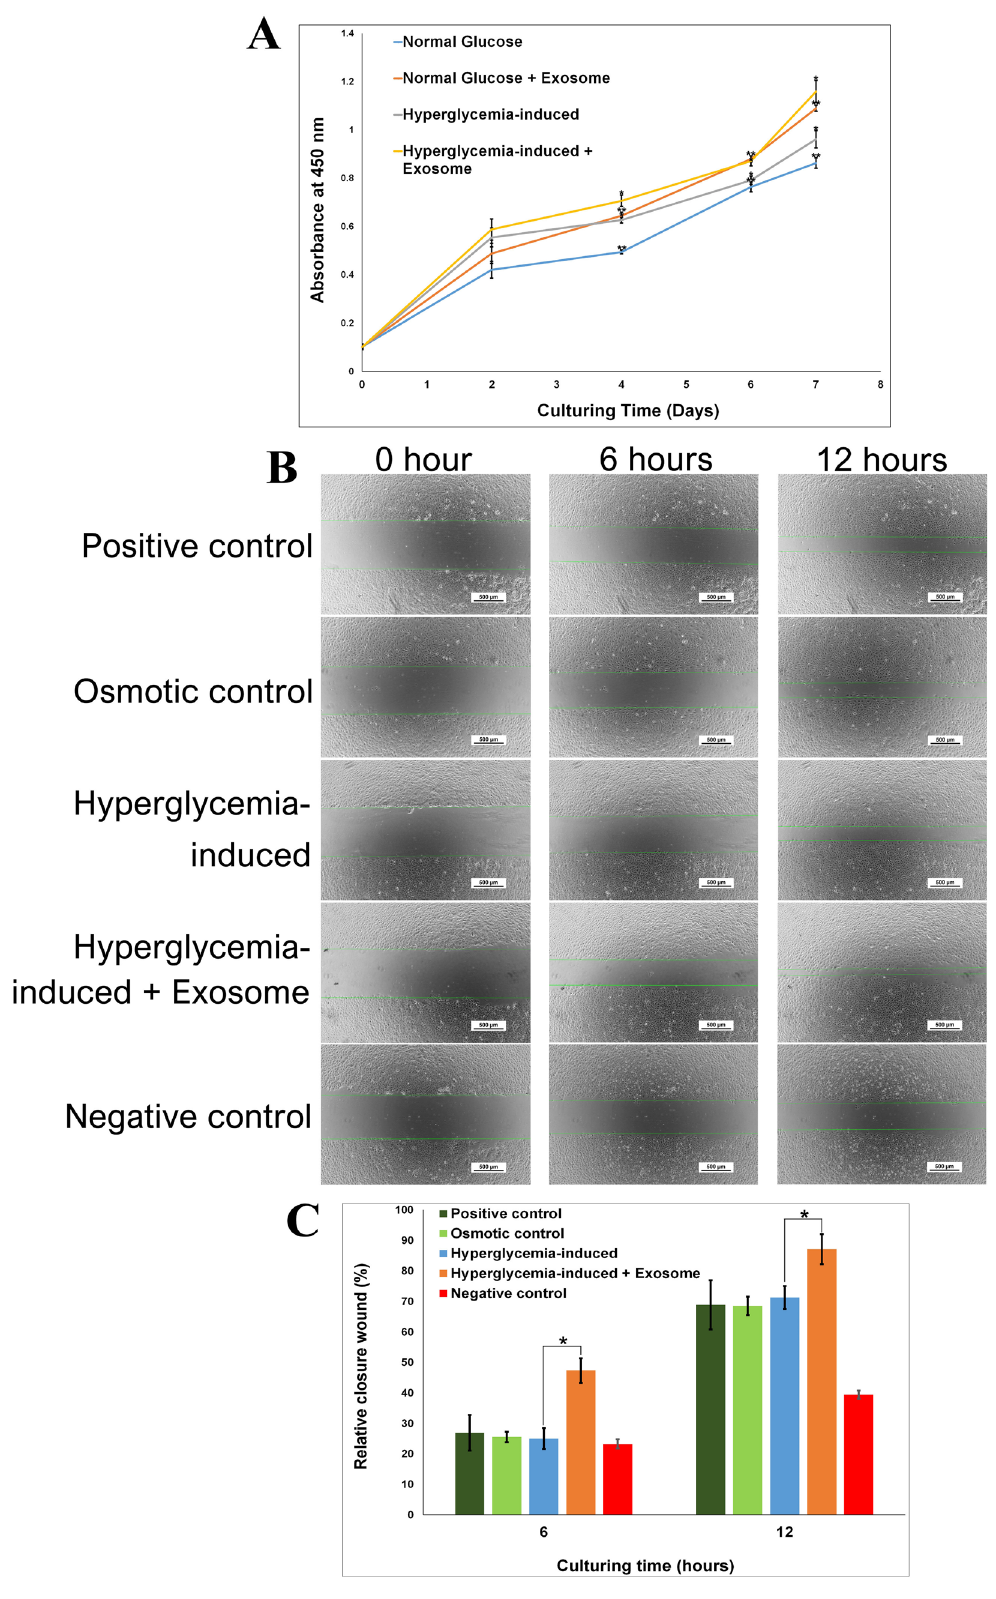
Figure 2- SHED-exosomes induce the growth and migration of hyperglycemia-induced endothelial cells. (A) The line charts represent the mean of the proliferation of HUVEC analyzed using the CCK-8 assay at different time points. **, indicates statistically significant differences between the group of exosomes and no exosome treatment in normal glucose concentration-induced HUVEC at day 4 (p=0.03), day 6 (p=0.03), and day 7 (p=0.02), * indicates statistically significant differences between the group of exosomes and no exosome treatment in high glucose concentration-induced HUVEC at day 4 (p=0.04), day 6 (p=0.03), and day 7 (p=0.02). (B) Analysis of HUVEC migration by in vitro scratch assay. Scale bars = 500 µm. (C) Quantification of the rate of scratch closure (%) in B. * indicates statistically significant differences between the group of exosomes and no exosome treatment in high glucose concentration-induced HUVEC at 6 hours (p=0.01) and 12 hours